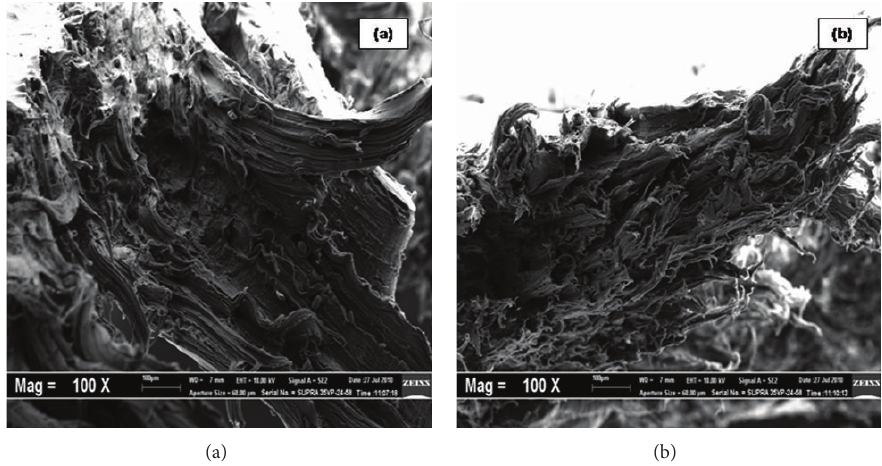
Figure 7: Tensile fracture surfaces of (a) 5 wt% EVA/organozeolite composite and (b) 25 wt% EVA/organozeolite composite.